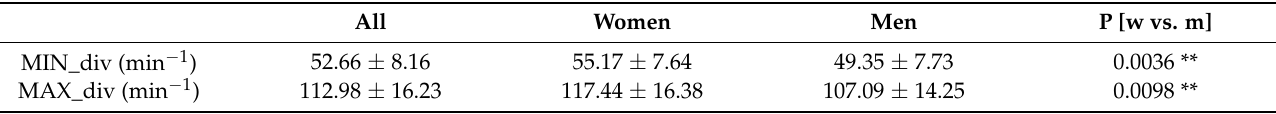
Table 2. The HR response to simulated diving in healthy men and women. All Women Men P [w vs. m]